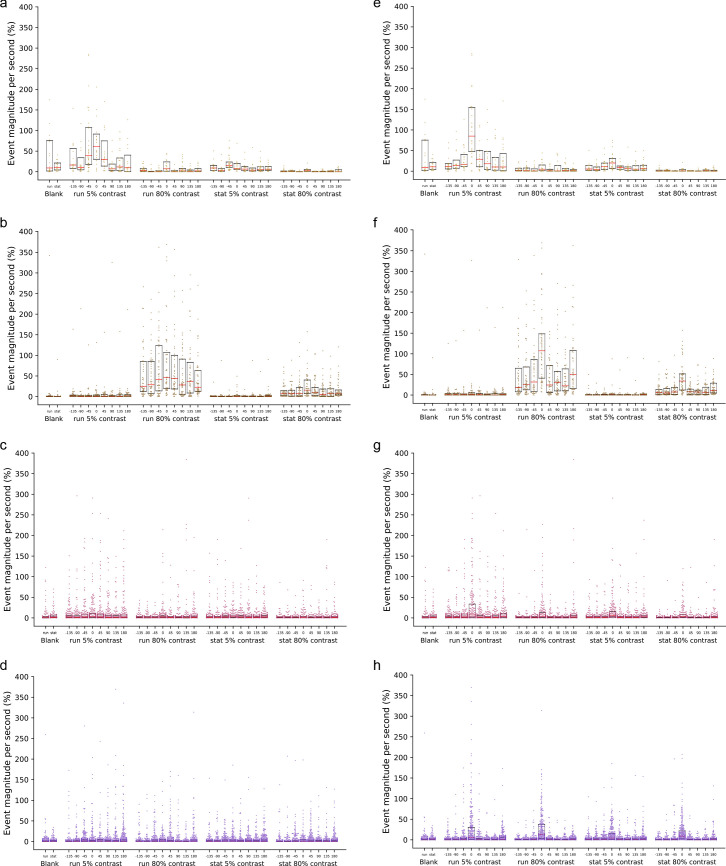
Distributions of single neuron response magnitudes across stimulus conditions for key Cre lines.(a) The distribution of responses of all VIP neurons in layer 2/3 of Vip mice by grating direction and contrast. Each dot is one neuron. Box plots show lower quartile, median (red bar), and upper quartile. (b) Same as a but for all SST neurons in layer 4 of Sst mice. (c) Same as a but for all pyramidal neurons in layer 2/3 of Cux2 mice. (d) Same as a but for all pyramidal neurons in layer 4 of Rorb mice. (e) Same as a but shown for stimulus direction relative to the cell’s peak direction (i.e. stimulus direction – peak direction). (f) Same as e but for all SST neurons in layer 4 of Sst mice. (g) Same as e but for all pyramidal neurons in layer 2/3 of Cux2 mice. (h) Same as e but for all pyramidal neurons in layer 4 of Rorb mice.